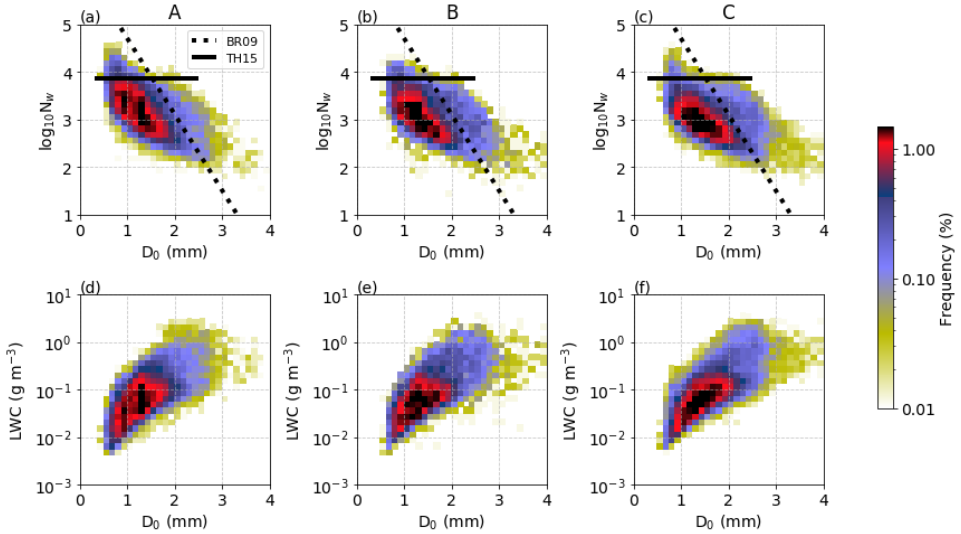
Figure 5. 2D histograms of log N w - D 0 ( a – c ) and LWC- D 0 ( d – f ) for Regions A, B, and C. The solid and dotted lines in ( a – c ) indicate TH15 and BR09 convective/stratiform separations, respectively.